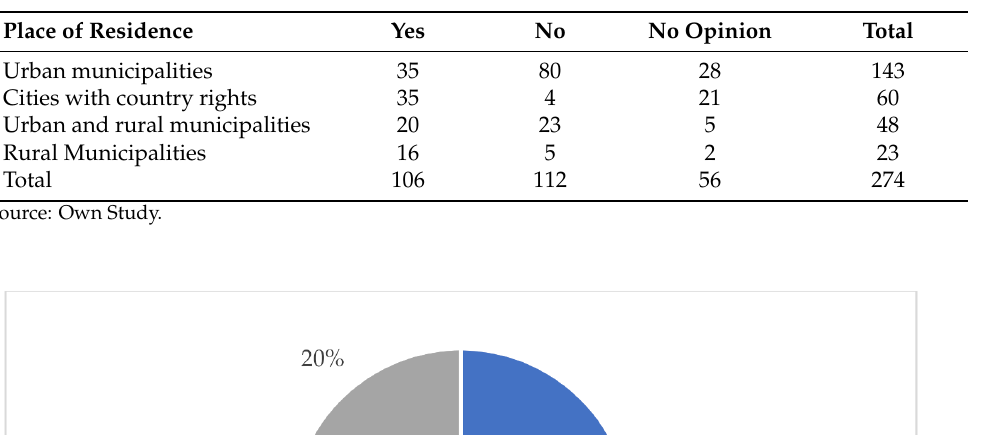
Figure 15. Knowledge of concepts and phenomena. Respondents could select only one answer—‘yes’ or ‘no’. a—do you know the opinions of your local community on the optimal energy mix, b—do you know how many prosumers are registered in your city/municipality, c—have you heard the term ‘energy cooperative’. Source: own study. Table 5. Residents’ concerns related to the implementation of EU climate and energy requirements in Poland.